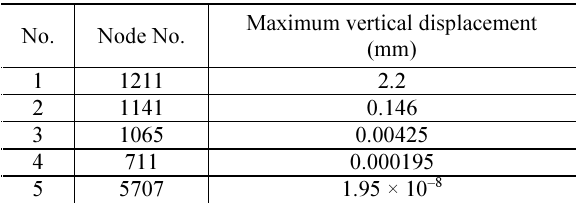
Type of element